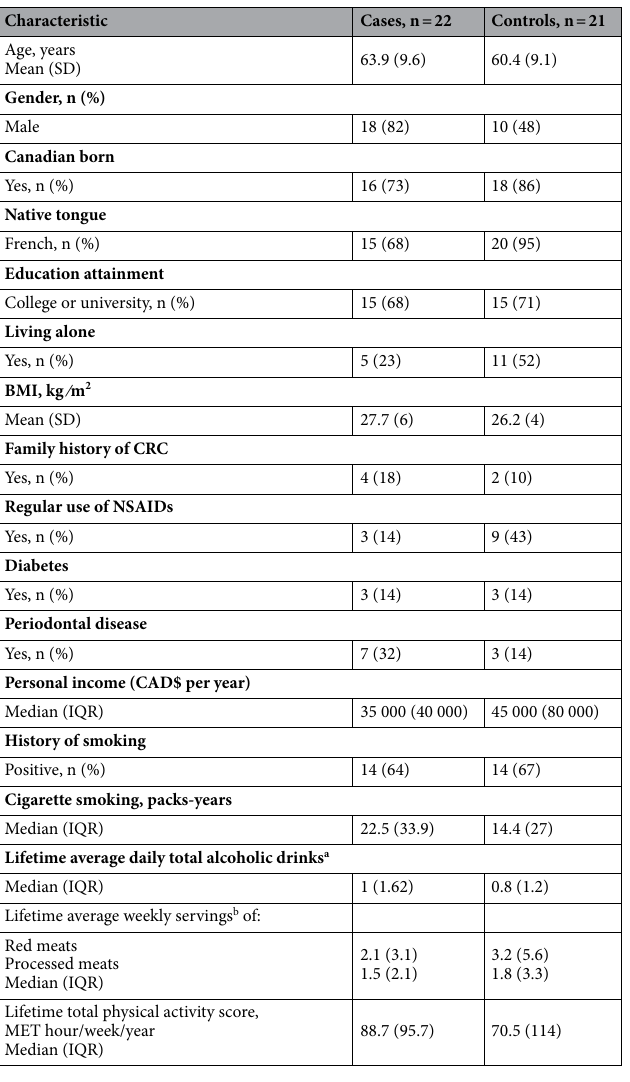
Table 2. Sociodemographic characteristics and potential colorectal neoplasm risk factors in study participants. BMI Body mass index, NSAID Non-steroidal anti-inflammatory drugs, CAD$ Canadian dollars, MET Metabolic equivalent of task; a: one drink including beer (355 ml bottle or can), wine (180 ml), or liquor (150 ml); b: 1 serving of red meats = 180–240 g, 1 serving of processed meats = 55 g; SD: Standard deviation; IQR: Interquartile